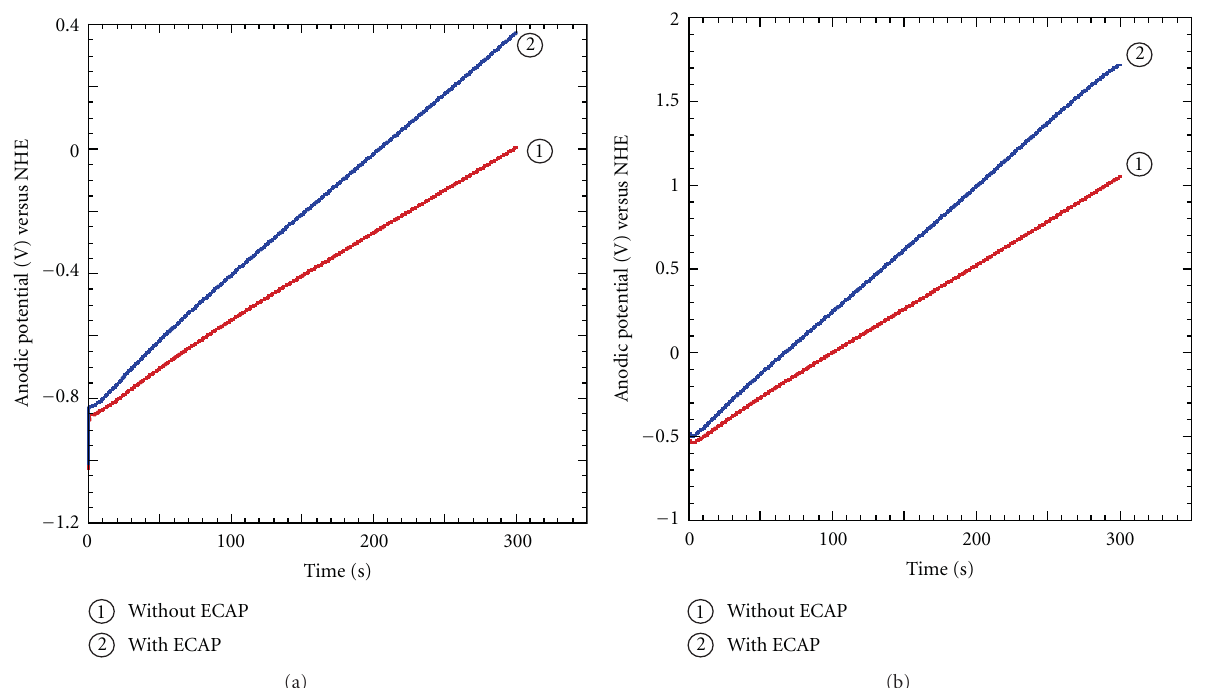
Figure 7: Time-dependence of anodic potential of pure Al (a) and Al (AA1100) (b) at 1A · m − 2 in a solution containing 0.5 mol · dm − 3 of H 3 BO 3 and 0.05mol · dm − 3 of Na 2 B 4 O 7 .